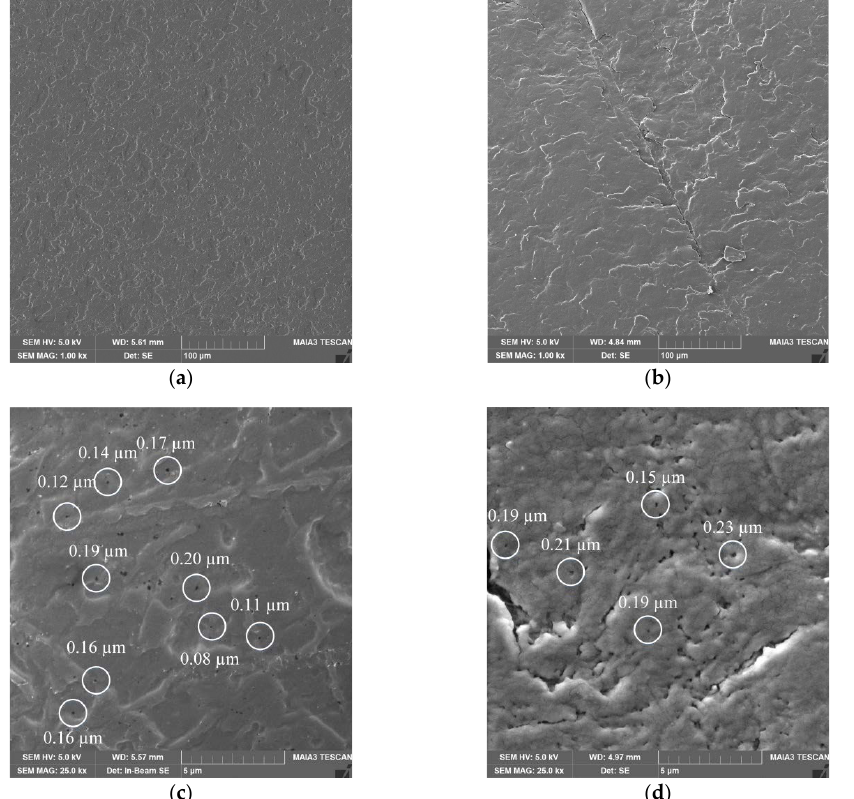
Figure 7. Scanning electron microscopy (SEM) micrographs of KF-110 films ( a , c ) and nail plates ( b , d ) at magnifications of 1000 × ( a , b ) and 25,000 × ( c , d ). White circles on ( c ) and ( d ) point on pores size of which was